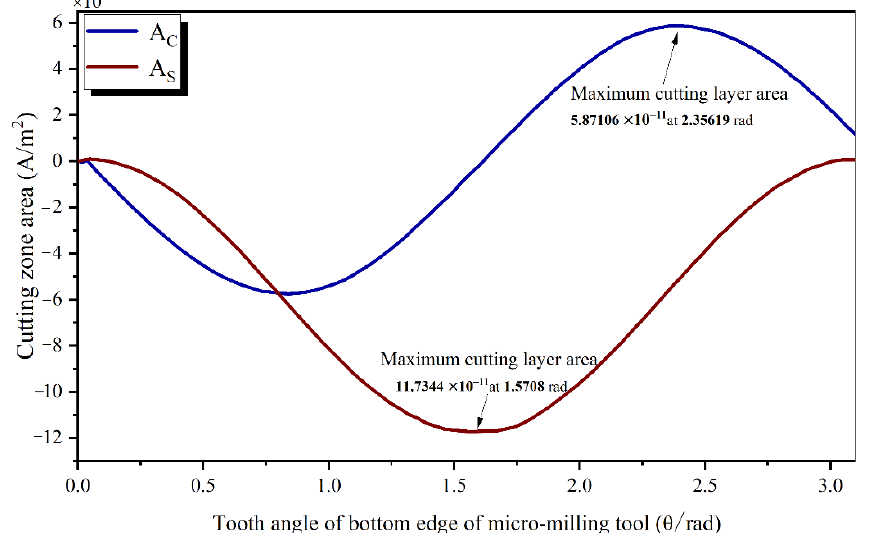
Figure 16. Decomposition of cutting layer area.